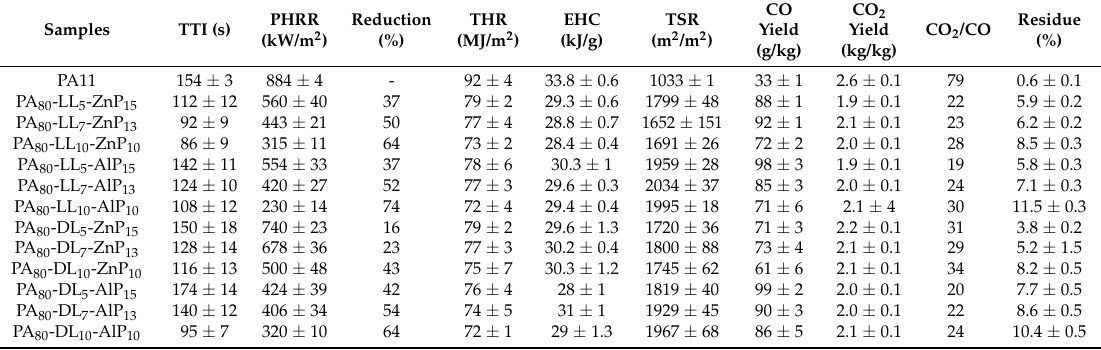
Figure 8. Heat release rate (HRR) and total heat release (THR) curves of polyamide 11 (PA11) blends. ( a ) and ( b ) for PA–DL–ZnP blends; ( c ) and ( d ) for PA–DL–AlP blends. Table 4. Cone calorimetry data for polyamide 11 (PA11) and its blends.